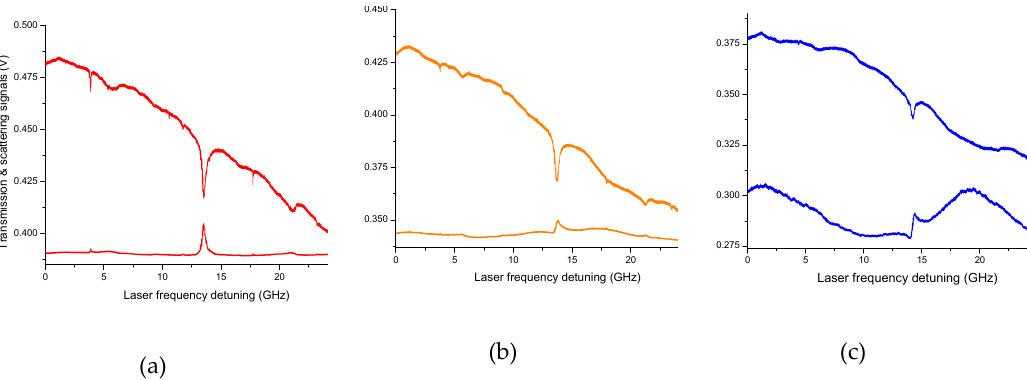
Figure 4. Fano-resonance behavior observed varying the distance between the laser beam and the droplet. The relative distance is decreased by ~1.6 μ m ( b ) and 2.8 μ m ( c ) from the WGM optimal droplet. The relative distance is decreased by ~1.6 µ m ( b ) and 2.8 µ m ( c ) from the WGM optimal coupling position ( a ). coupling position ( a